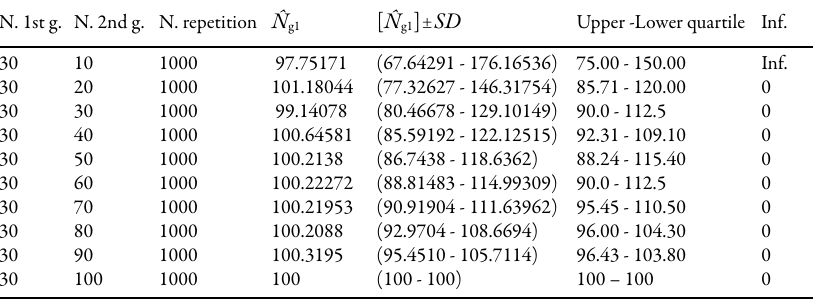
Table 2. The three statistics of experiment 2 of the virtual DNA data by simulation. The number of sampling from first generation is ‘N. 1st g.’. The number of sampling from second generation is ‘N. 2nd g.’. The number of repetitions of the simulation is ‘N. repetition’. The mean value of the estimated effective population size of the first generation (the first statistic) is  g1 . The standard deviation of  g1 (the second statistic) is [  g1 ]  SD. The upper quartile and lower quartile of the estimated effective population size of the first generation (the third statistic) is ‘Upper – Lower quartile’. If we could not measure  g1 after 1000 times, we denoted the situation as ‘Inf.’, which is the abbreviated form of Infinite (i.e. unmeasurable).